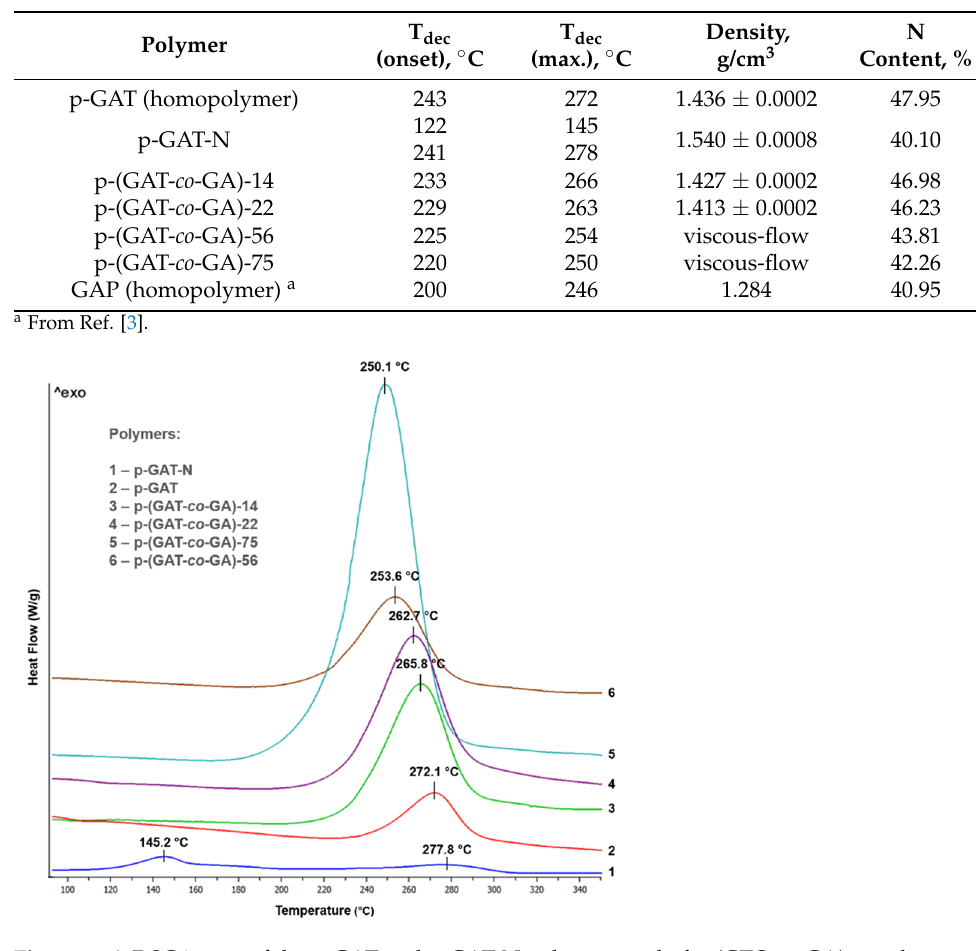
Table 2. Measurement results of thermal stability and density of polymers.